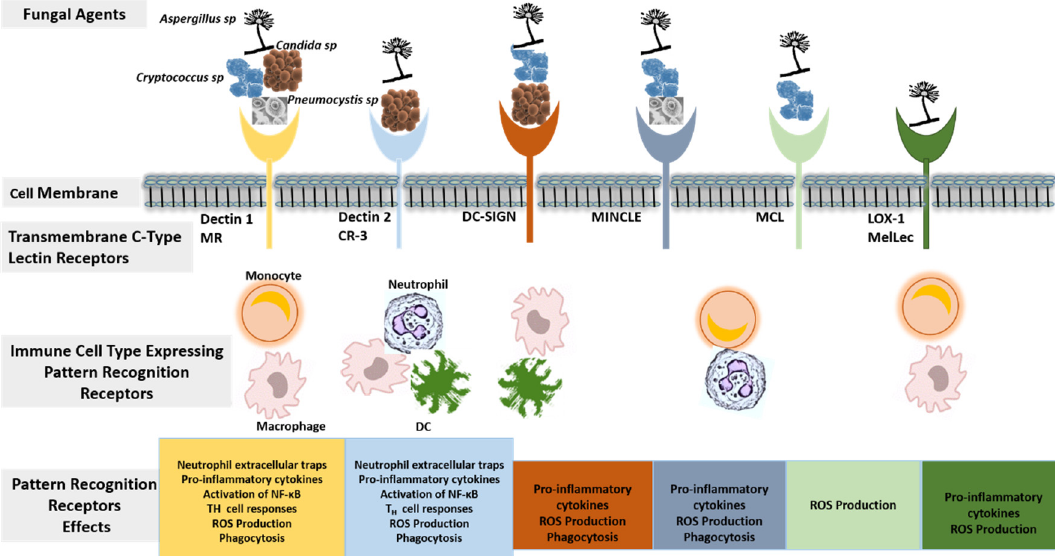
Figure 1. A schematic diagram showing the components of host innate immunity during interaction with fungal agents. Several transmembrane C-type lectin receptors including dectin-1, dectin-2, mannose receptor (MR), complement receptor-3 (CR-3), dendritic cell-specific intercellular adhesion molecule-3-grabbing nonintegrin (DC-SIGN), macrophage inducible C-type lectin (MINCLE), macrophage C-type lectin (MCL), and lectin-type oxidized low-density lipoprotein receptor 1 (LOX-1) are expressed on the cell surface of immune cells such as monocytes/macrophages, neutrophils, and dendritic cells (DC) and serve as important components of the pattern-recognition receptors (PRRs) that recognize invading fungi agents. Following the recognition of pathogen-associated molecular patterns (PAMPs) of the fungus by the immune cells through their PRRs, multiple anti-fungal activities are triggered downstream, including the production of neutrophil extracellular traps by neutrophils, the production of proinflammatory cytokines such as nuclear factor kappa B (NF-kB), the production of reactive oxygen species (ROS), the activation of adaptive immune response, and the phagocytosis of fungal organisms.